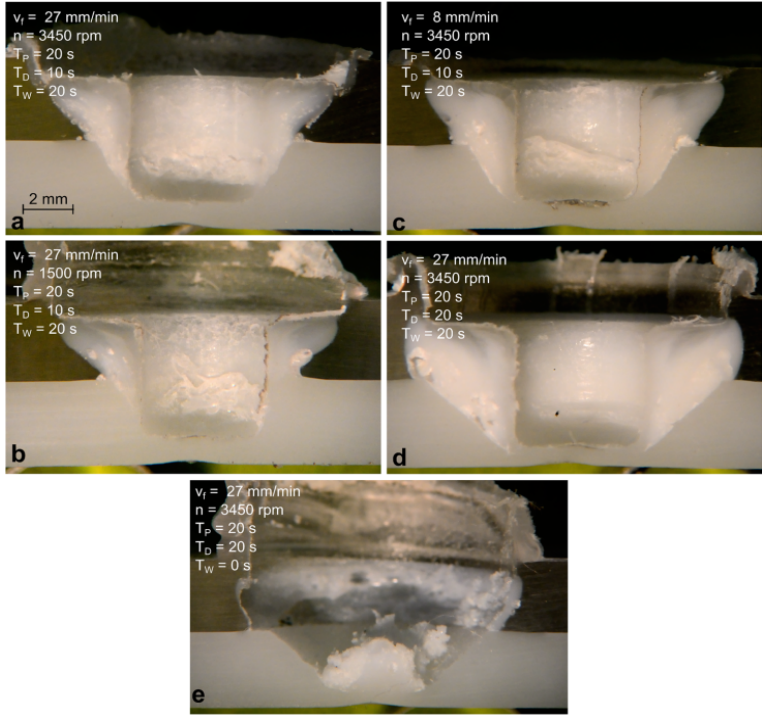
Figure 32. Influence of process parameters on welds morphology [78]. ( a ) reference condition; ( b ) reduction of tool rotation speed; ( c ) reduction of plunging speed; ( d ) increase of dwell time and ( e ) reduction of the waiting